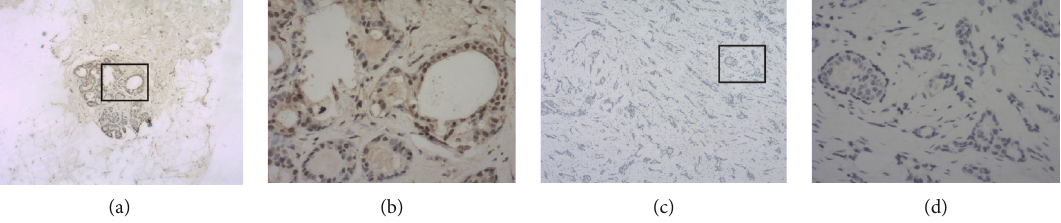
Figure 6: Immunohistochemistry staining for ZNF385B. The expression of ZNF385B in breast cancer cell was decreased. (a, b) IHC staining of paratumor breast tissues ((a) × 40, (b) × 400); (c, d) IHC staining of breast cancer tissues ((c) × 40, (d) ×